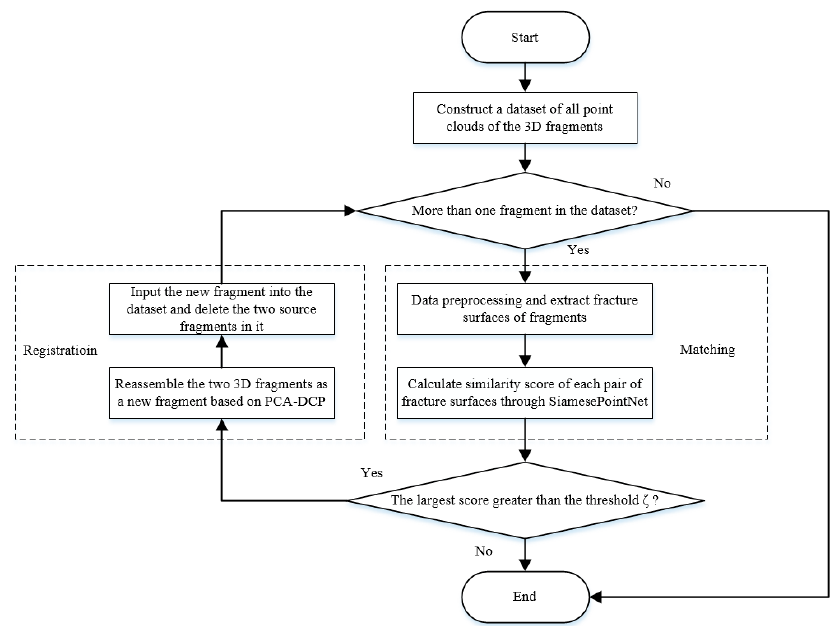
Figure 1. The flowchart of the proposed method.